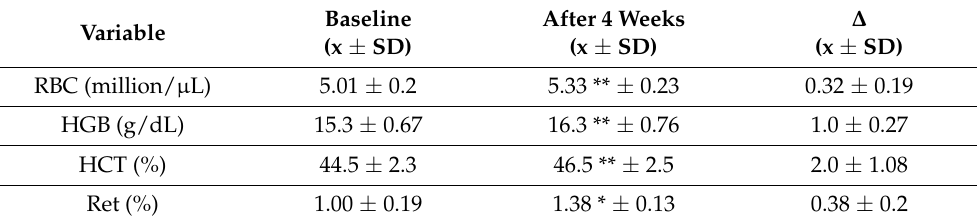
Table 4. Selected hematological variables in the experimental LH–TL group during initial and final